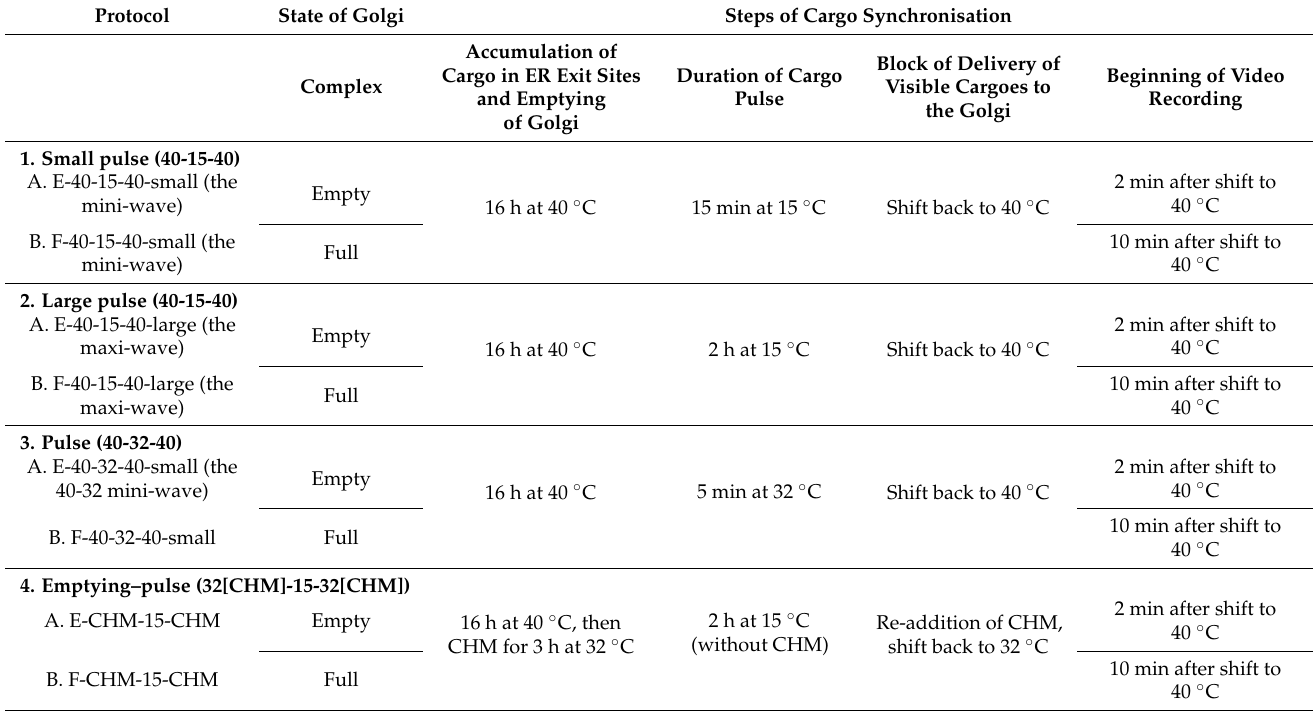
Table 3. Protocols of cargo